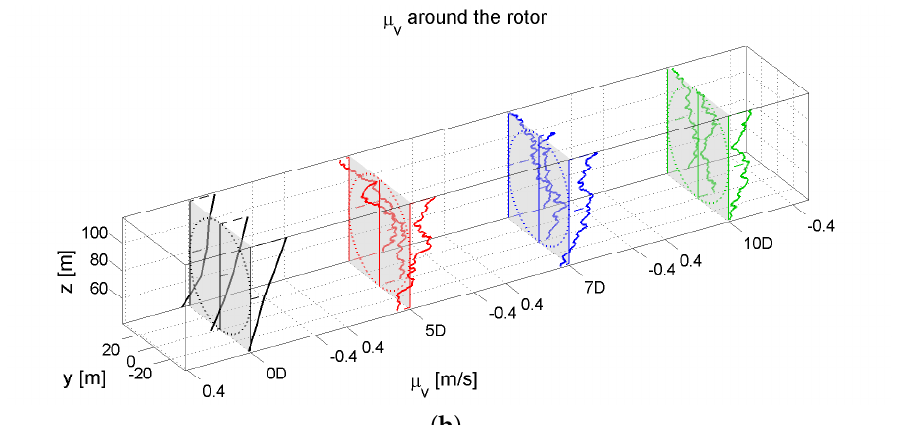
Figure 8. Spatial variation µ v in the waked field versus the free-stream field: ( a ) variation of µ v in vertical planes; and ( b ) profile of µ v .